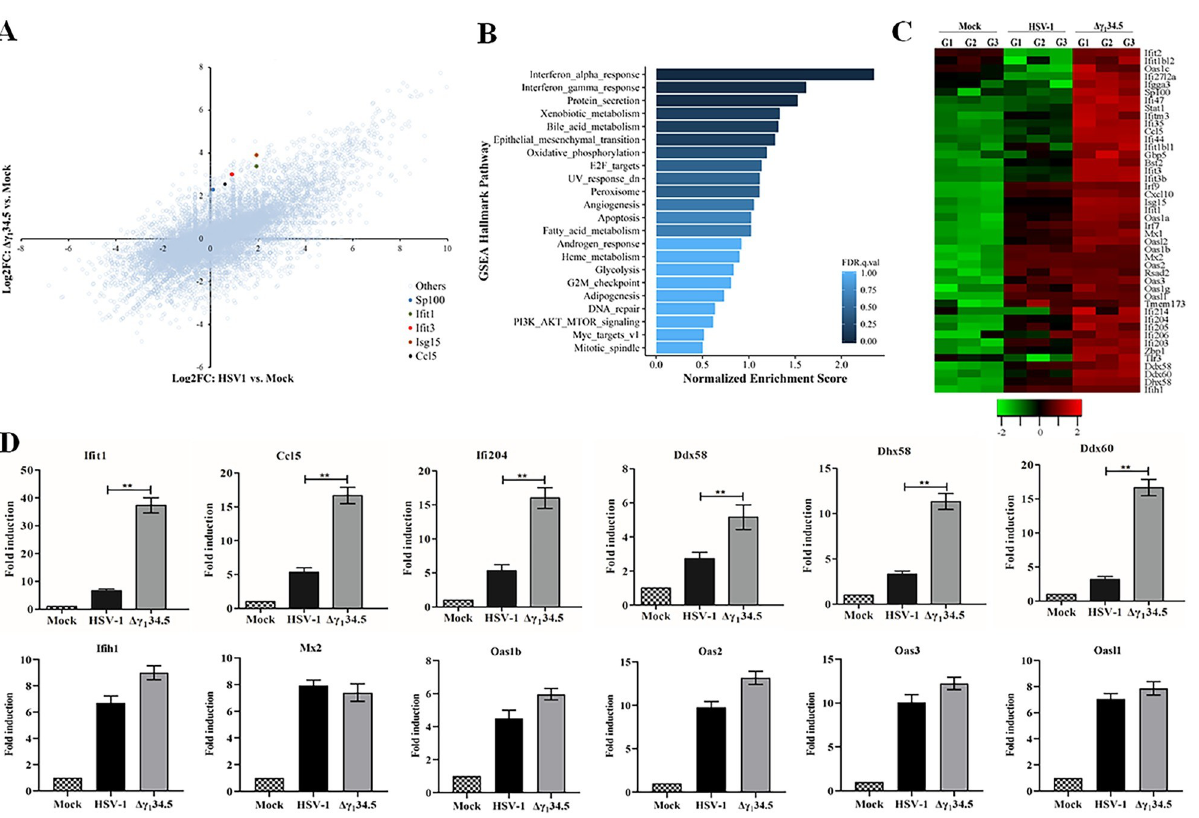
Fig 1. HSV-1 γ 1 34.5 downregulates immune genes linked to RNA sensing. (A) Effects of γ 1 34.5 on global host gene expression. MEF cells were mock infected, infected with wild type HSV-1 or Δγ 1 34.5 (5 pfu/cell). At 8 h postinfection, RNAs were extracted for RNA deep sequencing. Data from triplicate samples, processed as described in the Materials and Methods, are presented as Scatterplot. X axis denotes log2 fold change in HSV-1 to mock ratios. Y axis indicates log2 fold change in Δγ 1 34.5 to mock ratios. Dots are single genes. A few representative genes upregulated more by Δγ 1 34.5 than by wild type HSV-1 are highlighted. (B) GSEA hallmark analysis on genome wide gene expression. Pathways enriched in gene sets upregulated by Δγ 1 34.5 relative to wild type HSV-1 are ranked based on the normalized enrichment score (NES). False discovery rate (FDR) q value < 0.25 is defined as significantly enriched. Nominal p values are also indicated for top ranked pathways. (C) Heatmap visualization of RNA transcripts linked to the IFN response. The map shows 46 genes including IFN-stimulated genes, intracellular DNA sensors and RNA sensors. G1, G2 and G3 are distinct experimental replicates. The data represents the Log2FC (Fold Changes). (D) Effect of γ 1 34.5 on antiviral gene expression. MEF cells infected as in (A) were subjected to quantitative PCR analysis to test the expression of Ifit1, Ccl5, Ifi204, Ddx58, Dhx58, Ddx60, and Ifih1, Mx2, Oas1b, Oas2, Oas3, and Oasl1. The results were expressed as fold activation relative to 18S ribosomal RNA, with standard deviations among triplicate samples. The data were statistically analyzed by one-way ANOVA ( �� , P <